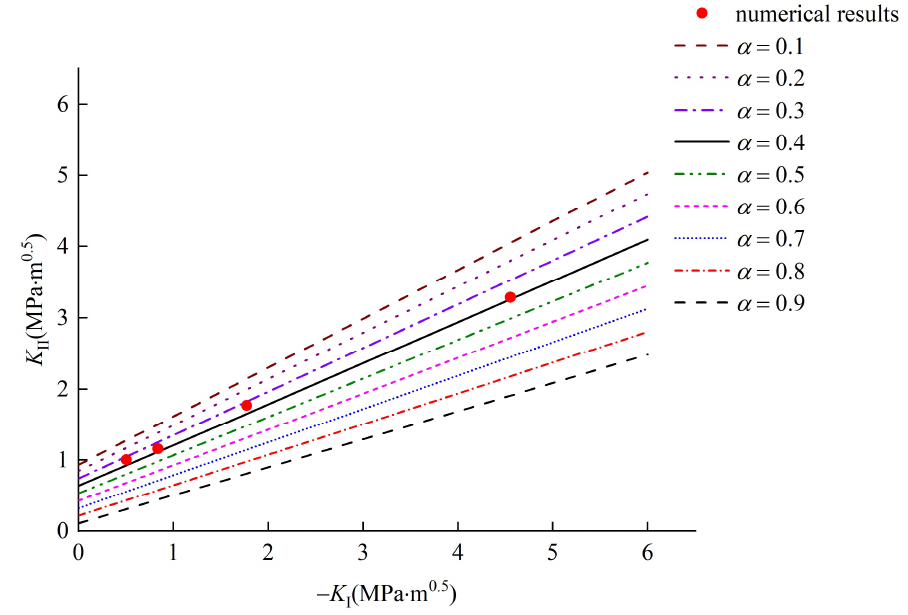
Figure 9. Comparison between the numerical results and the theoretical results.